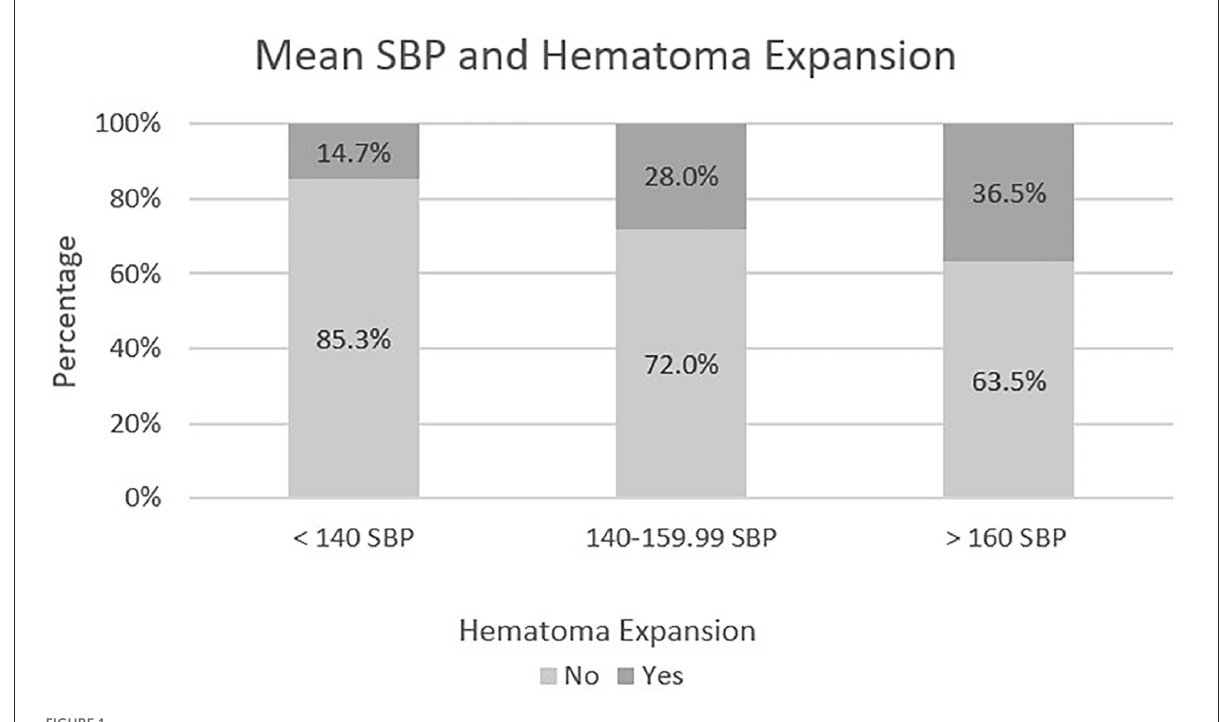
FIGURE1 Mean SBP in relation to hematoma expansion.